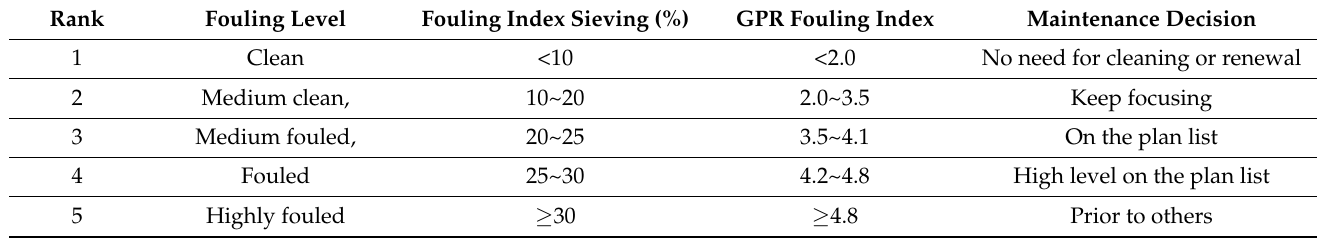
Figure 16. Integrated inspection vehicle with GPR system. Table 3. Ballast fouling level standard.